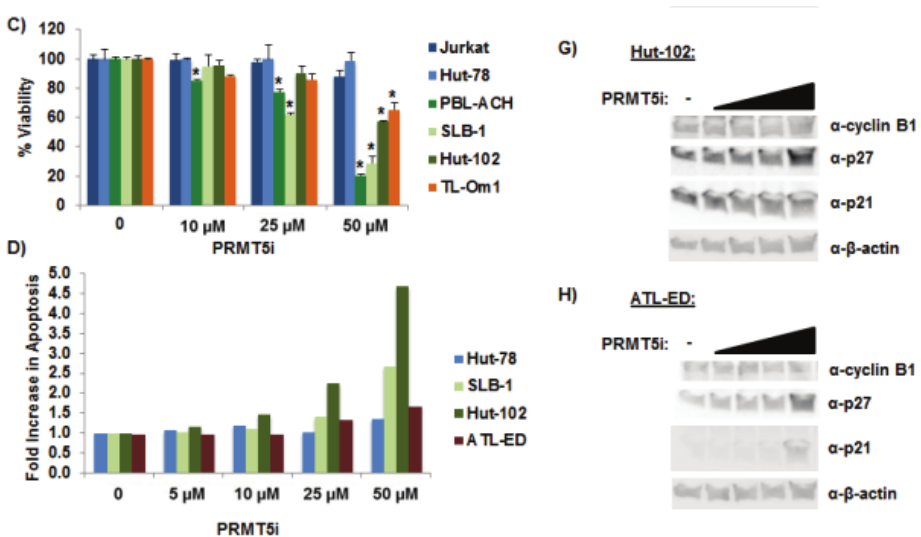
Figure 5. Selective inhibition of PRMT5 decreased cell proliferation and viability. ( A ) Cellular proliferation was measured using an MTS cellular proliferation assay in Jurkat, Hut-78, PBL-ACH, SLB-1, Hut-102, and TL-Om1 cell lines after 48 h of PRMT5i treatment. (Jurkat and Hut-78 are HTLV-1 negative lines; PBL-ACH, SLB-1, and Hut-102 cells are HTLV-1-tranformed lines; TL-Om1 is an ATL-derived Tax-negative line.) Data are presented in histogram form with mean and standard deviations from duplicate experiments. Vehicle treatment for each cell type was set at 1.